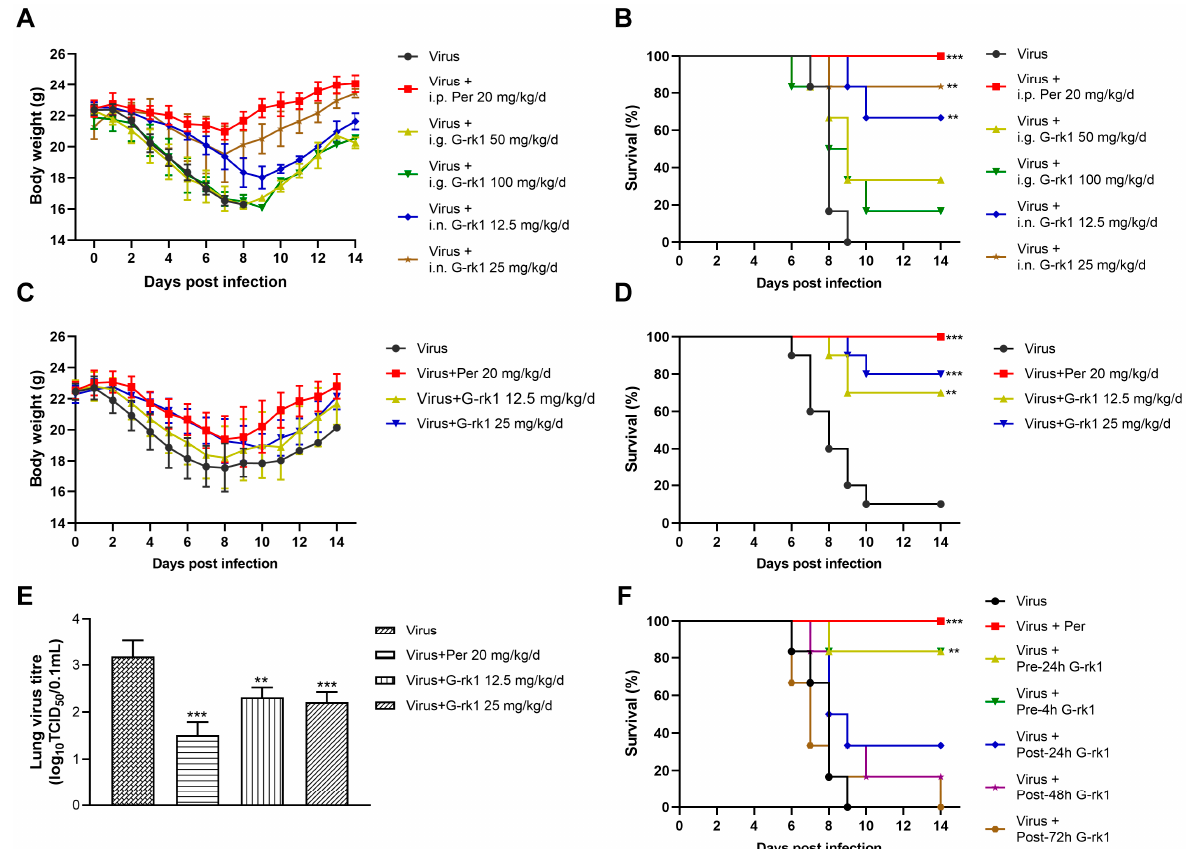
Figure 5. G-rk1 treatment decreases BALB/C mice’s morbidity and mortality from PR8 infection. In ( A – E ), BALB/C mice were infected with 5 × LD 50 of PR8 and treated with G-rk1 via intragastric administration (i.g.) or intranasal inoculation (i.n.) or with PBS as a control (once daily for a consecutive 6 days starting a day before infection). Peramivir, a positive control, was administered daily via intraperitoneal injection (i.p.). Daily assessments were conducted for weight loss ( A , C ) and mortality ( B , D ) (n = 6 for ( A ) and ( B ); n = 10 for ( C , D ), i.n). In ( E ), the effect of G-rk1 administered intranasally on lung virus titers in PR8-infected mice at 4 dpi (n = 5) is shown. In ( F ), BALB/C mice were infected with 5 × LD 50 of PR8, and the initial 25 mg/kg/d of G-rk1 was intranasally introduced either at 24 (Pre-24 h) or 4 h (Pre-4 h) prior to or 24 (Post-24 h), 48 (Post-48 h), or 72 h (Post-72 h) post-infection, respectively, followed by G-rk1 treatment for 6 consecutive days. Survival rates in all groups were monitored daily for 14 days. Statistical significances are denoted by ** p < 0.01, and *** p < 0.001 compared to Virus Control.